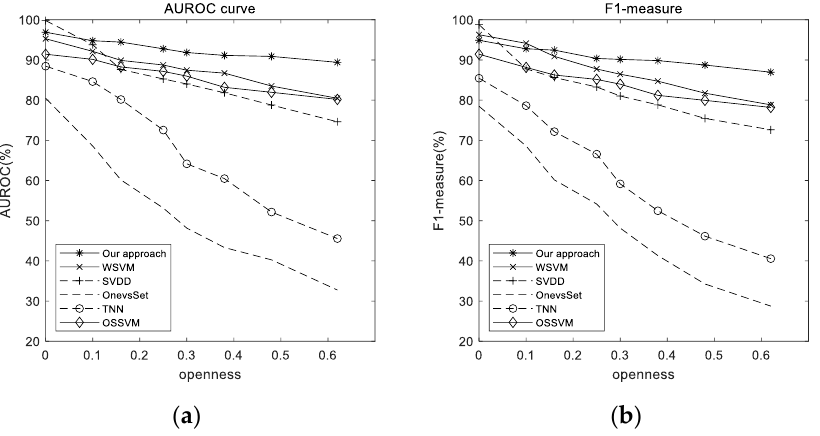
Figure 7. AUROC and F1-measure with increasing openness: ( a ) AUROC and ( b ) F1-measure.